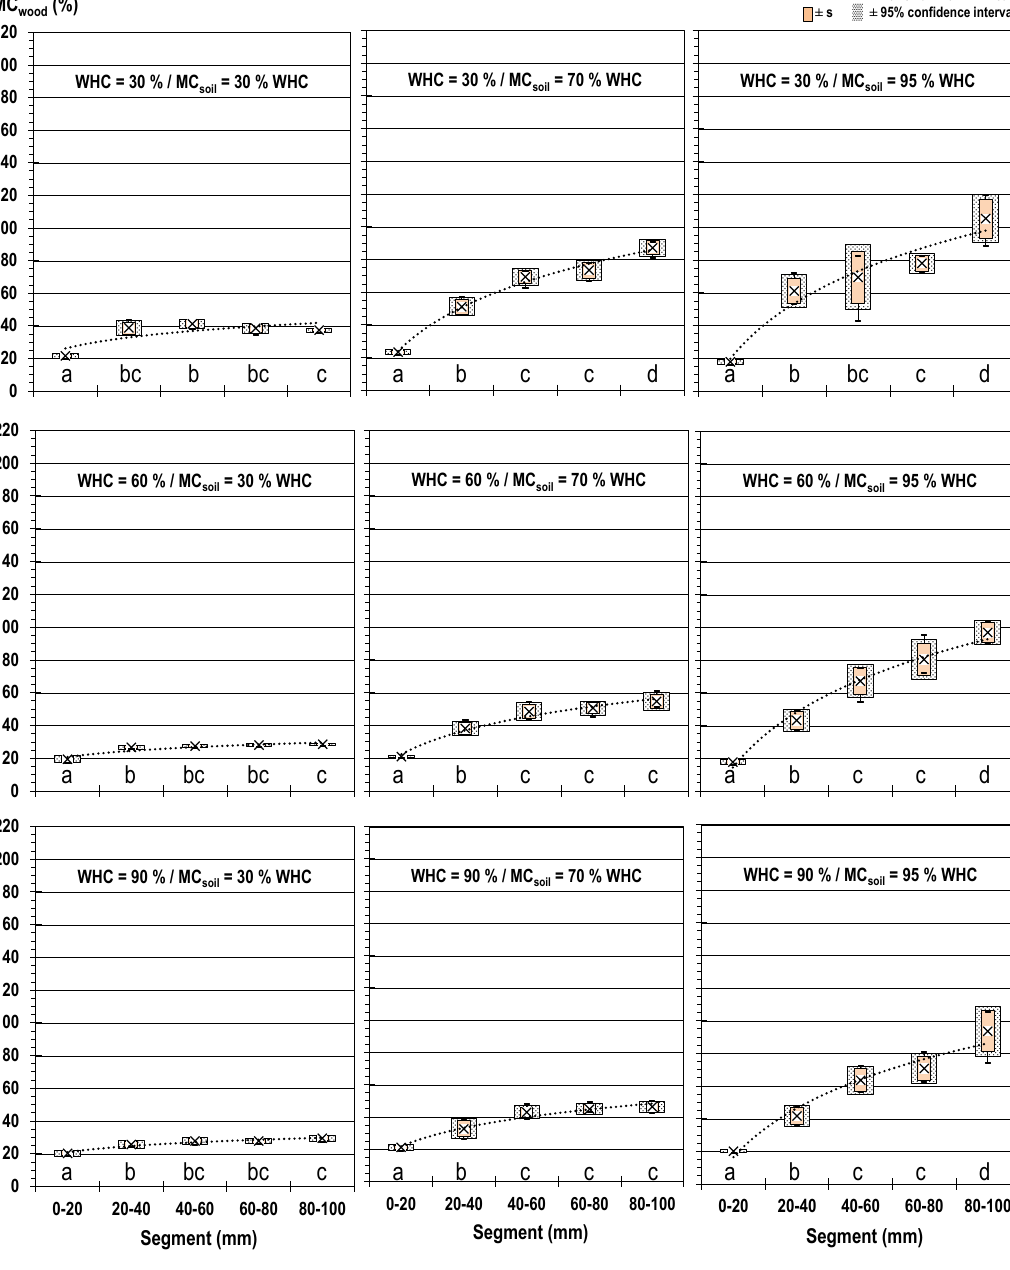
Figure 8. Distribution of MC wood in Douglas fir specimens buried to 4/5 of their length (20 – 100 mm) in different TMCs. Different letters indicating significant differences between groups at p < 5% according to a Student t -test for non-paired samples.